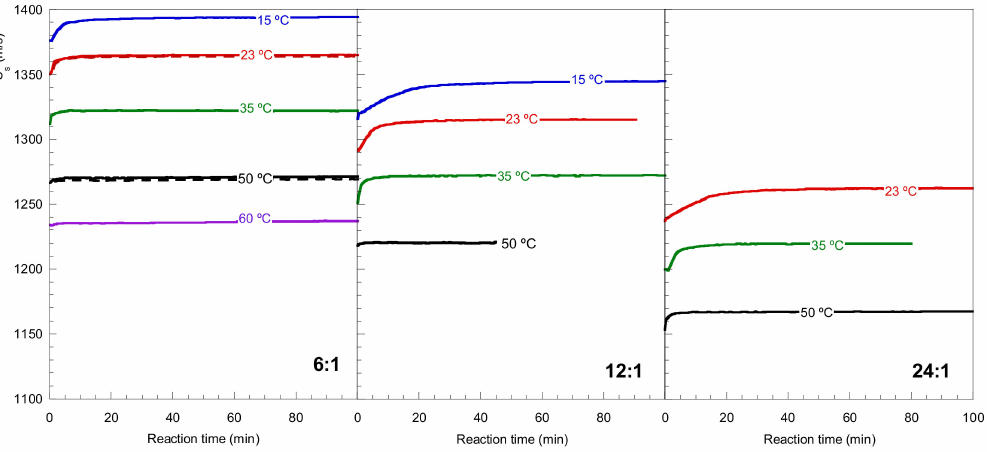
Figure 1. Experimental speed of sound data for reactions carried out at different temperatures and alcohol/oil molar